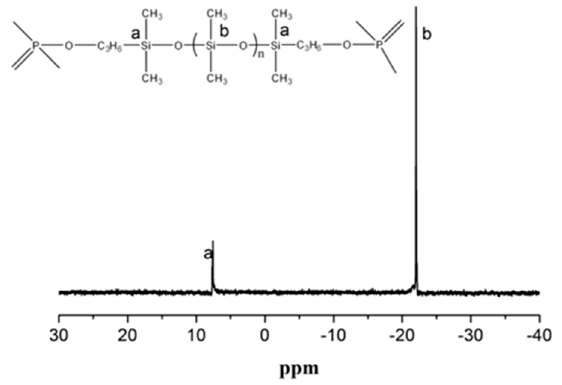
Figure 4. The 29 Si NMR spectrum of the synthesized HSPCTP.